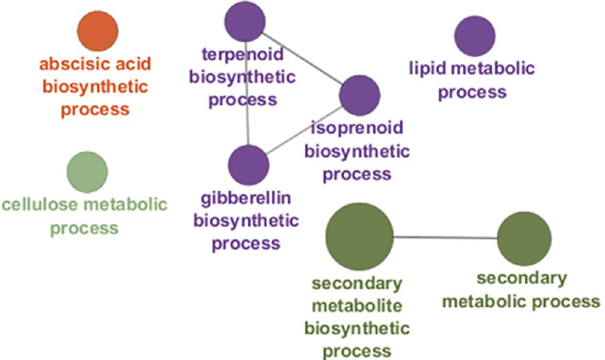
Figure 5. GOE analysis of the BOT region. Different colours indicate different ontologies. The bigger the circle, the higher the statistical